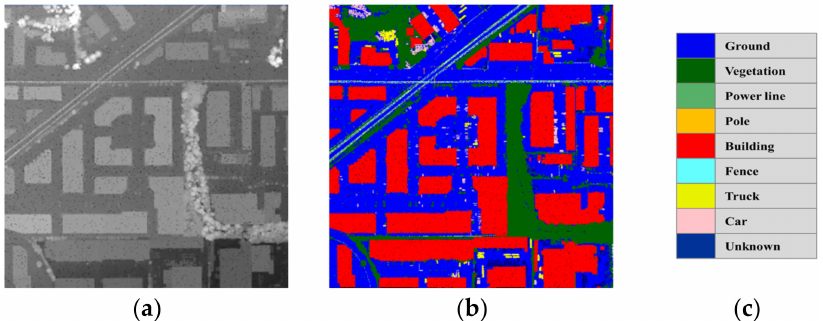
Figure 4. Examples of DALES datasets: ( a ) LiDAR data; ( b ) semantic segmentation label data; ( c ) object categories with 8 class labels.